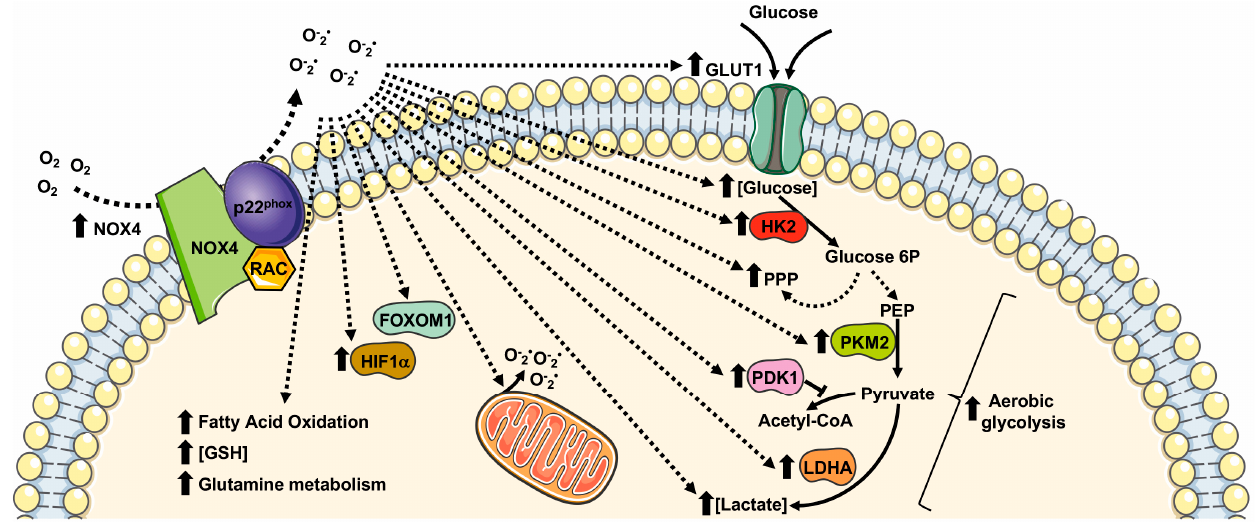
Figure 3. Metabolic pathways supported by NOX4 expression and NOX4-related ROS generation.